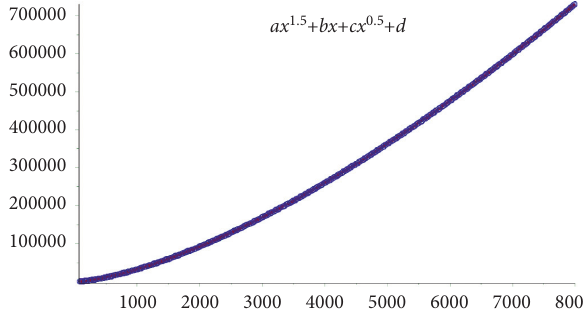
����� 􏽰 ��� √ � √ n ) /12 ) and the fitting 2/3 2 h ( n )